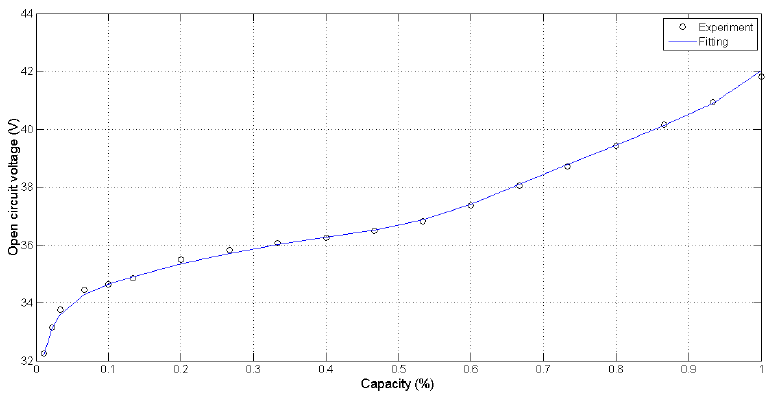
Figure 6. A comparison between experimental measurements and the fitted curve.